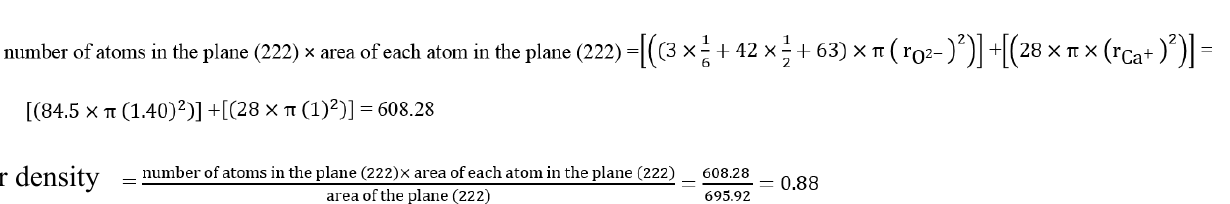
Figure 6. Geometry of planes and calculations of planar density of ( a ) (222) super cell (3 × 3 × 3) and ( b ) (222) super cell (8 × 8 × 8).